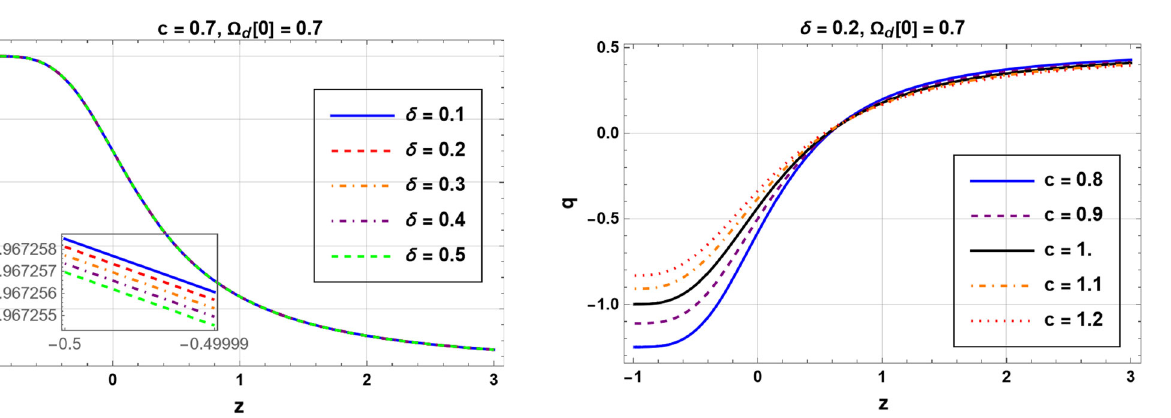
Fig. 2 NTHDE density parameter (cid:6) d with c = 0 . 7 and δ = 0 . 1 to 0 . 5 is plotted w.r.t. redshift z by considering (cid:6) d [ z = 0 ] ≈ 0 . 7 , M 2 p = 1